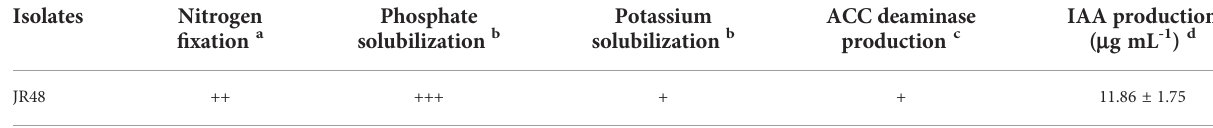
TABLE 1 In vitro determination for PGP characteristics of